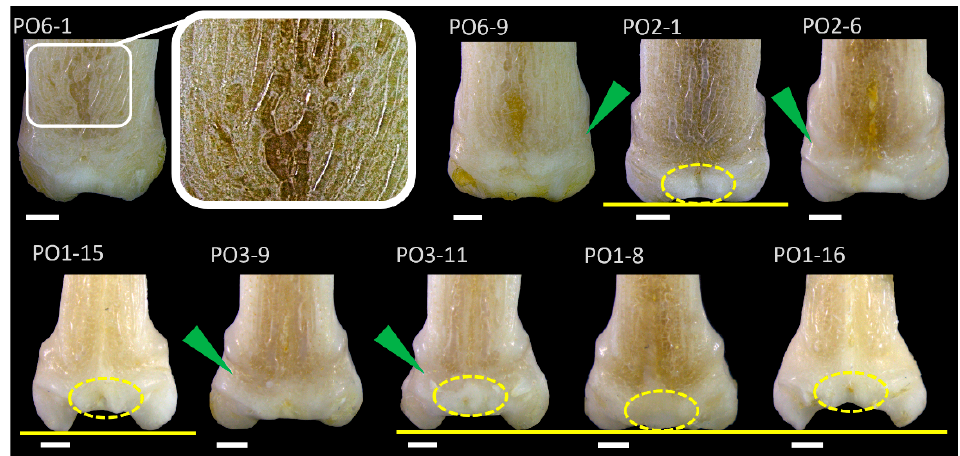
Figure 2. Microscopic images of the anterior view of different pinnules of different specimens of P. bichir . Each number corresponds to the respective position on the dorsal fin. Scale bars = 1 mm. The white rectangle zooms in on the ganoin ornamentation. The green triangle identifies different levels of concavity below the transversal pad. The yellow lines evidence various relative positions of the median process (dashed oval) compared to the base line of the pinnule (continuous line). Scale = 1 mm.